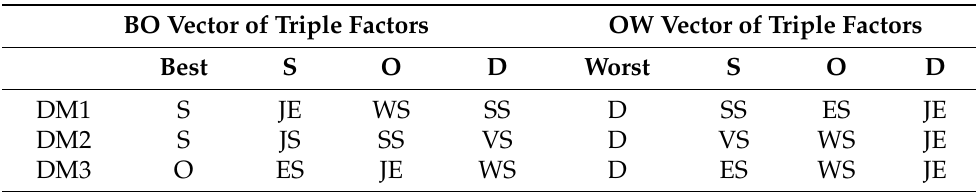
Table 4. Decision-makers ideas about risk